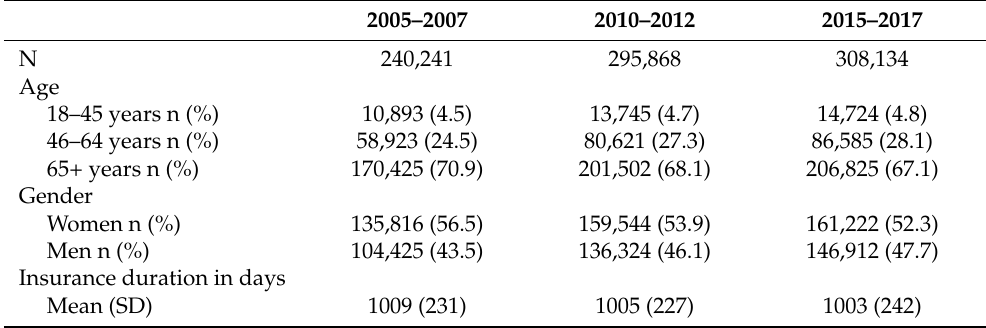
Table 1. Population characteristics.